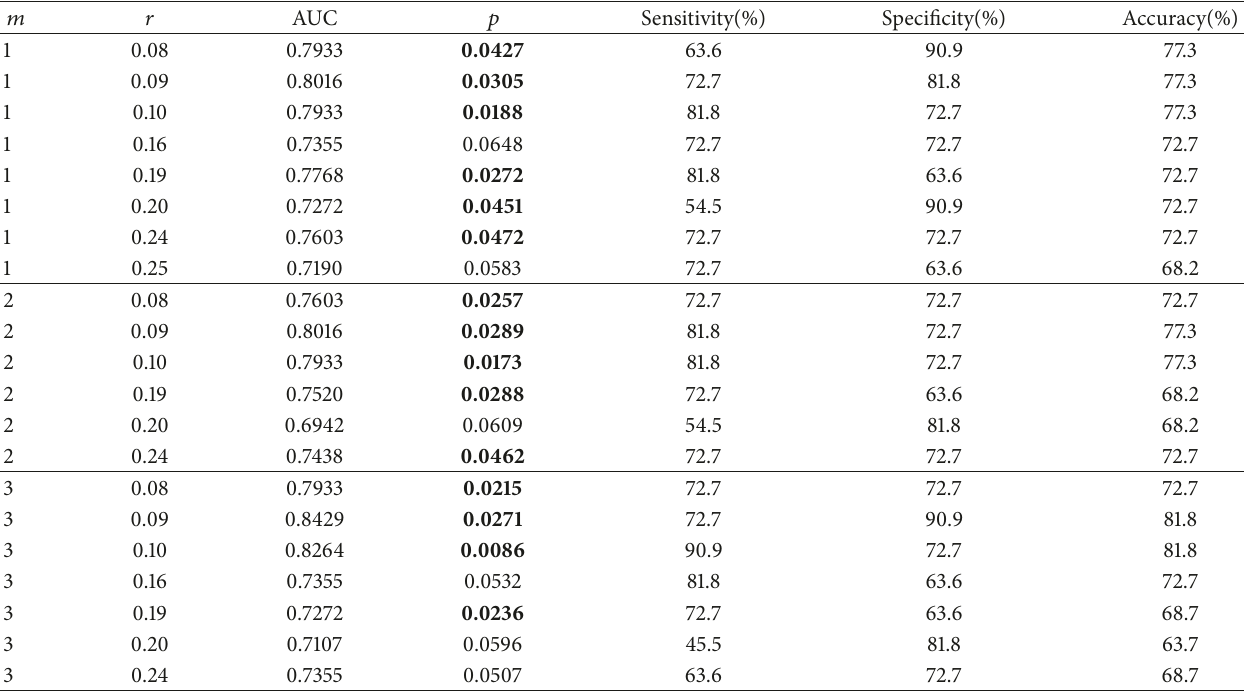
Table 4: Classification analysis results for SampEn in terms of highest AUC, including sensitivity, specificity, and accuracy, and their significance 𝑝 .